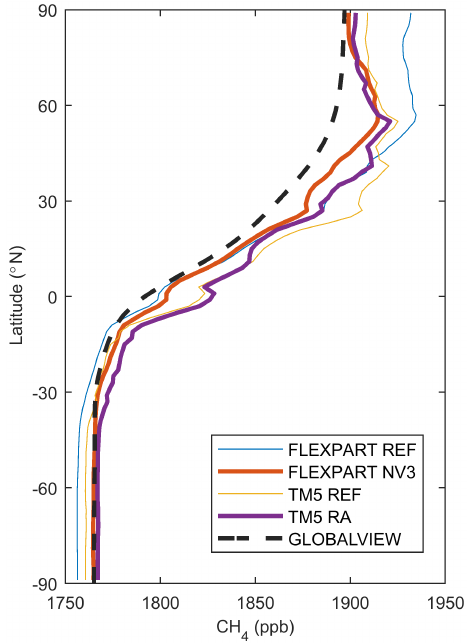
Figure 10. Zonal mean surface methane (ppb) in 2013 based on FLEXPART CTM, TM5 and